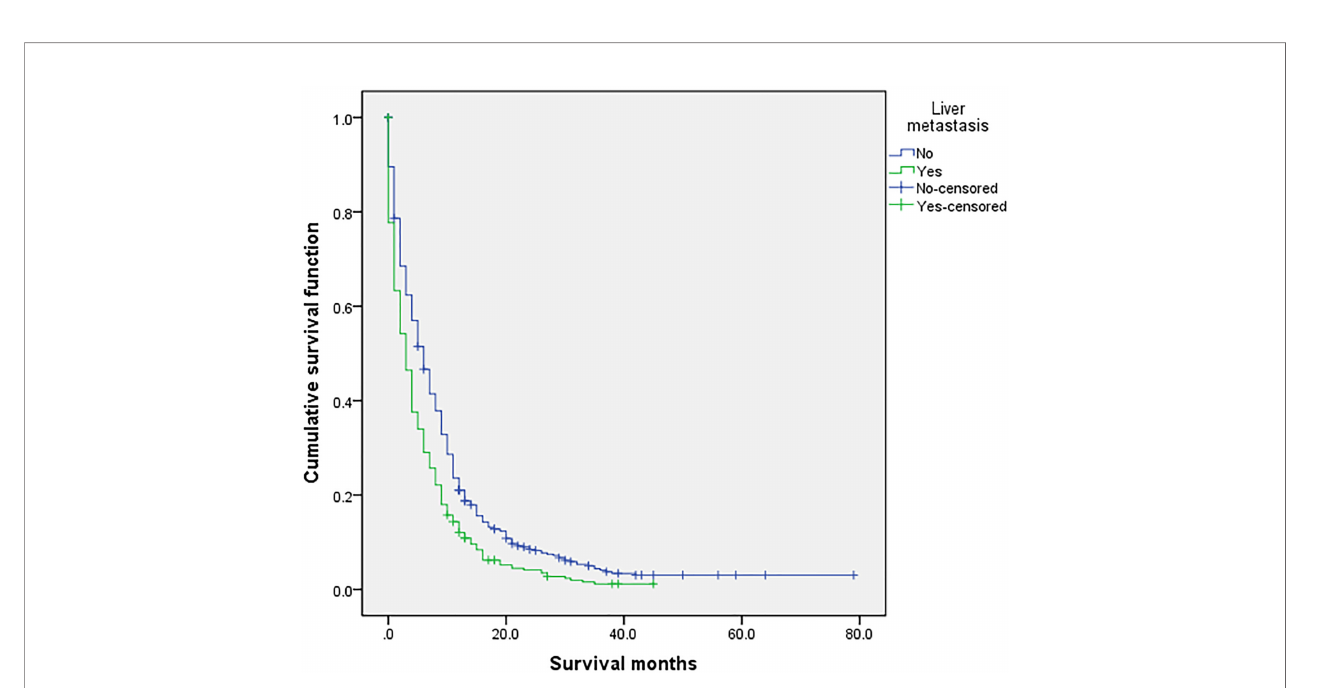
FIGURE 6 | Univariate analysis of liver metastasis. In the organ metastasis group (n = 870), univariate analysis of liver metastasis and no liver metastasis showed that P < 0.001 was obtained by Kaplan – Meier survival analysis log rank (mental Cox). There was signi fi cant difference between the two